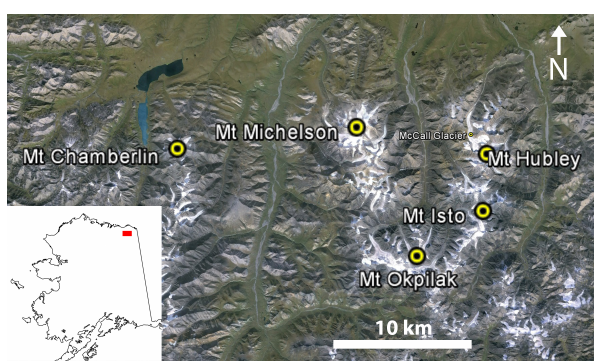
Figure 1. The five tallest peaks in the US Arctic are located within about 40km of each other in northeastern Alaska, within the Arctic National Wildlife Refuge.